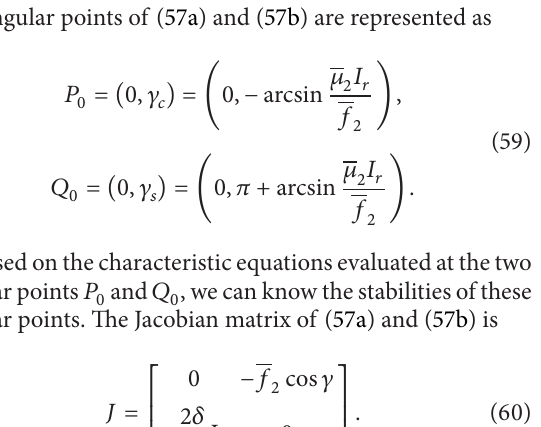
When 𝜀 = 0 , (56a) and (56b)